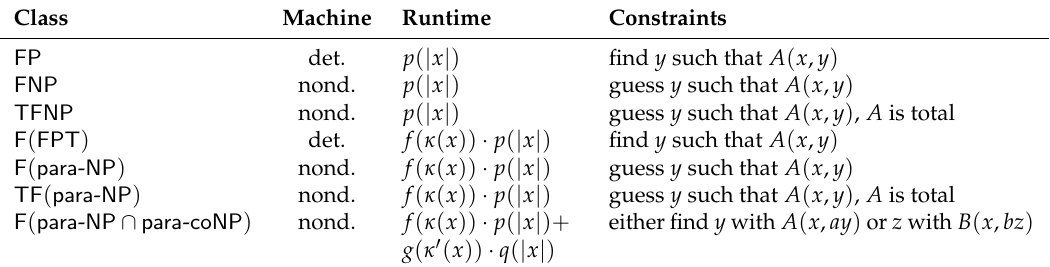
Table 1. Overview of function complexity classes. In the machine column, ‘det.’/‘nond.’ abbreviates ‘deterministic’/‘nondeterministic’. In the runtime column, p and q are polynomials, f and g are